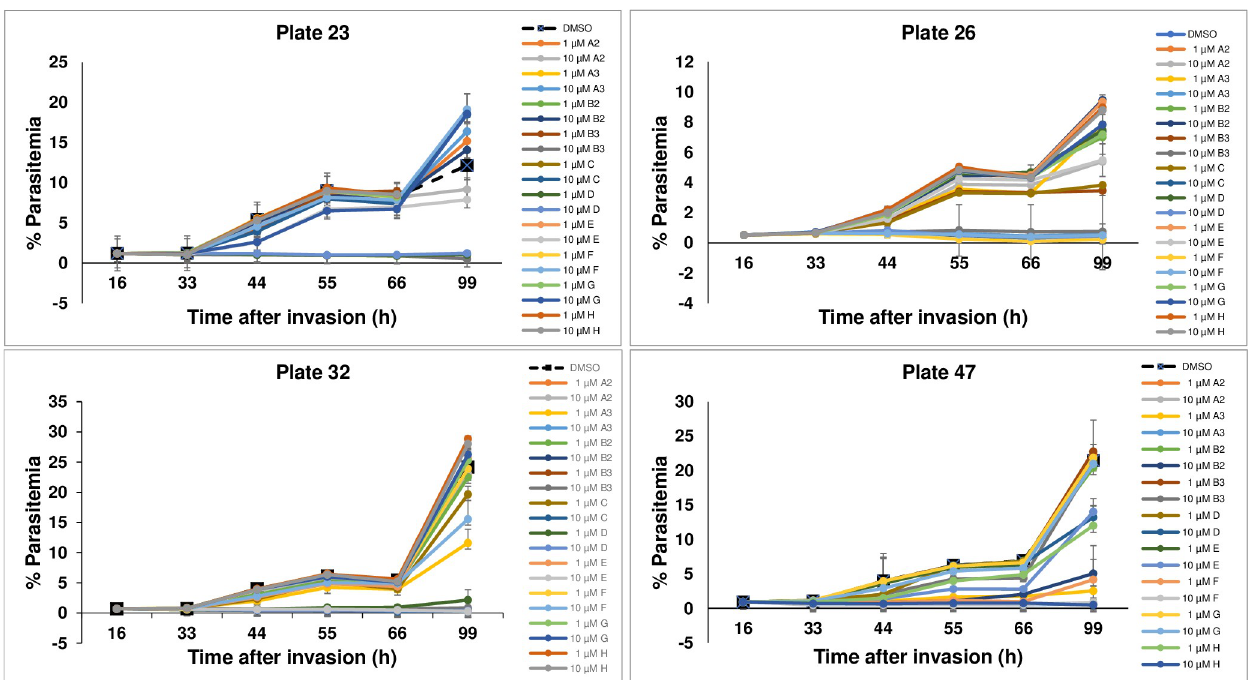
Fig 1. Percent parasitemia of P . falciparum infected RBCs as a function of time following treatment with de-identified tyrosine kinase inhibitors at 1 μ M and 10 μ M concentrations. The drugs were encoded based on their locations in 96-well plates as explained in the Methods section. Cultures were synchronized as described in Methods and kinase inhibitors were added ~16 hours after RBC invasion. The drug treatments were conducted in duplicate.